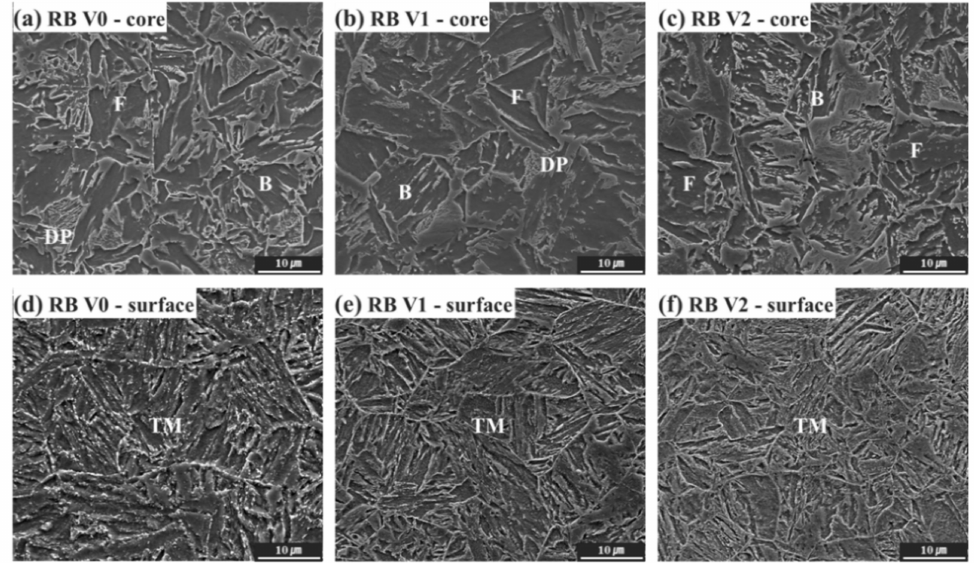
Figure 3. SEM micrographs of the Tempcore rebars for various locations and V contents: ( a – c ) in the core and ( d – f) on surface; ( a , d ) RB Vo, ( b , e ) RB V1 and ( c , f ) RB V2; F, DP, B and TM denote ferrite, degenerated pearlite, bainite and tempered martensite,